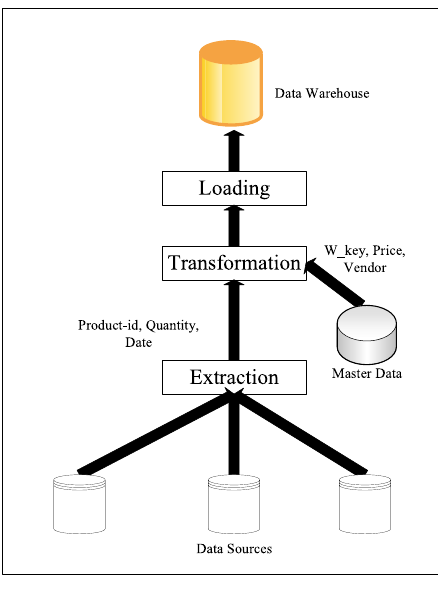
Figure 1. An example of stream-relation join during the transformation